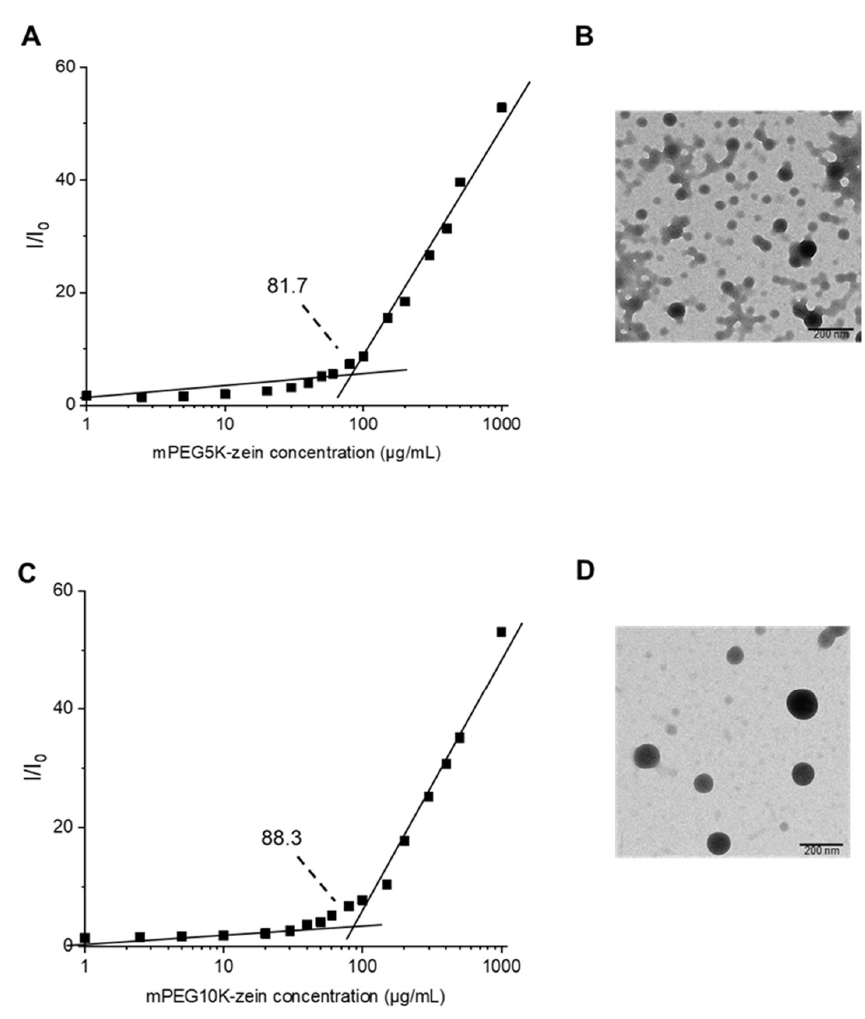
Figure 2. Assembly of mPEG ‐ zein into micelles: relative fluorescence intensity (I/I o ) of Nile red in the function of the concentration of mPEG5K ‐ zein ( A ) and mPEG10K ‐ zein ( C ), unstained TEM images of mPEG5K ‐ zein ( B ) and mPEG10K ‐ zein micelles ( D ) (scale bar: 200